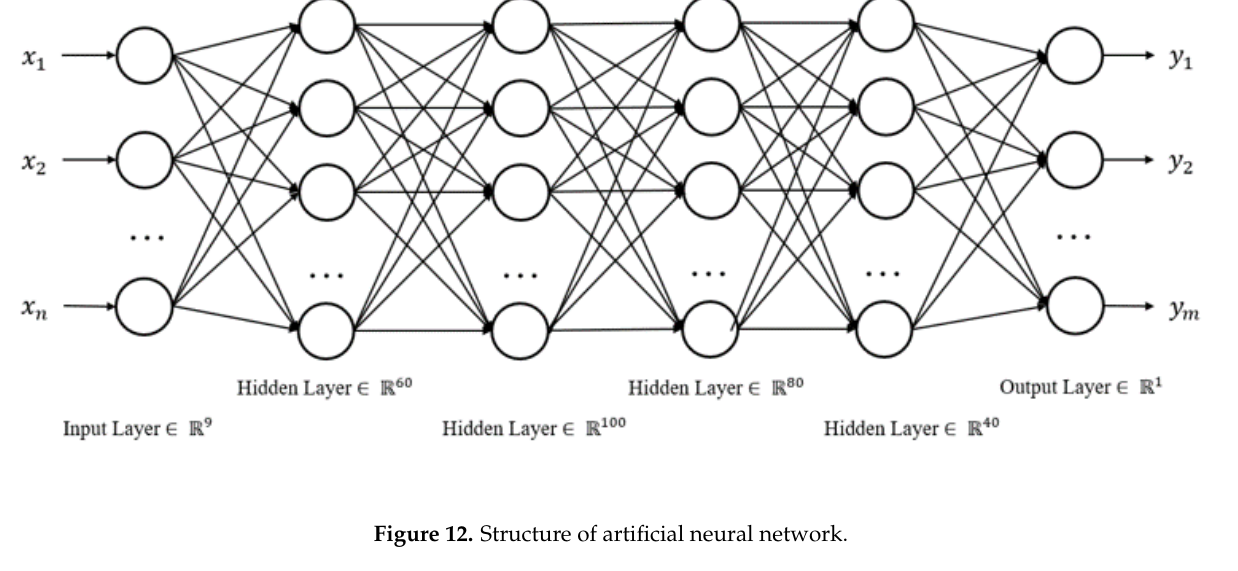
Figure 12. Structure of artificial neural